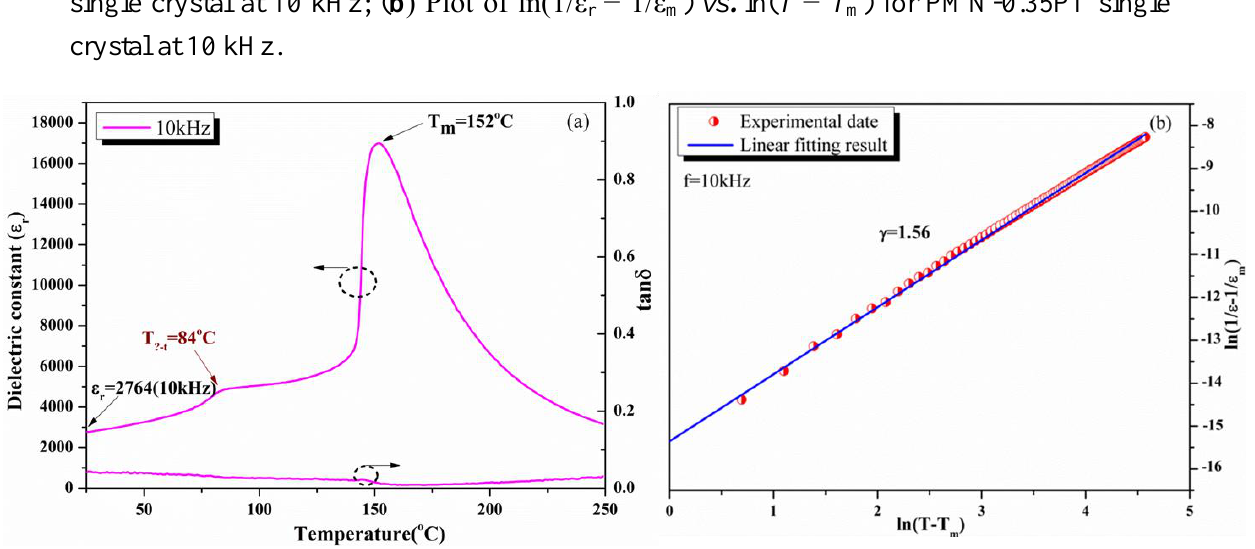
PMN-0.35PT c − 1/ε ) vs. ln( T − T ) for PMN-0.35PT single r m m